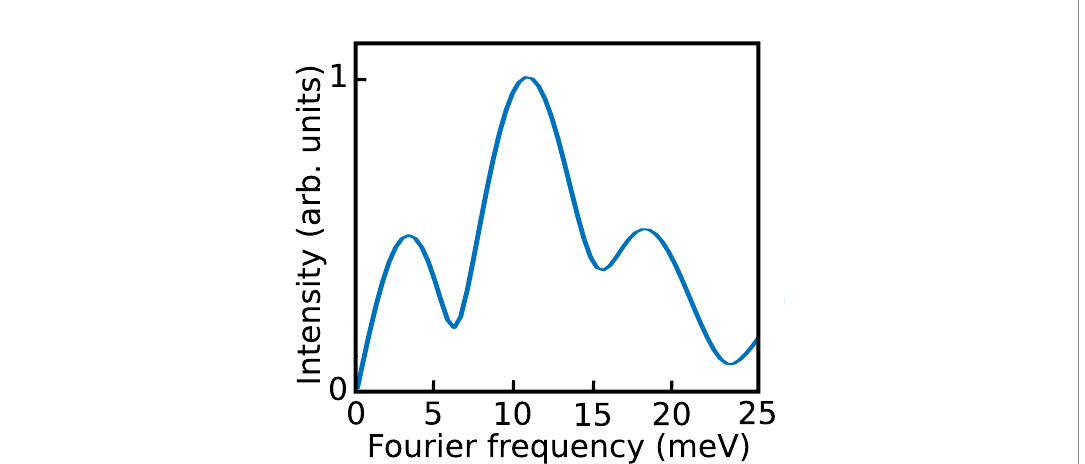
Figure 6. Fourier analysis of the quantum beating in the ion yield observed with HH19 at a NIR intensity of 2 . 6 × 10 13 Wcm − 2 (figure